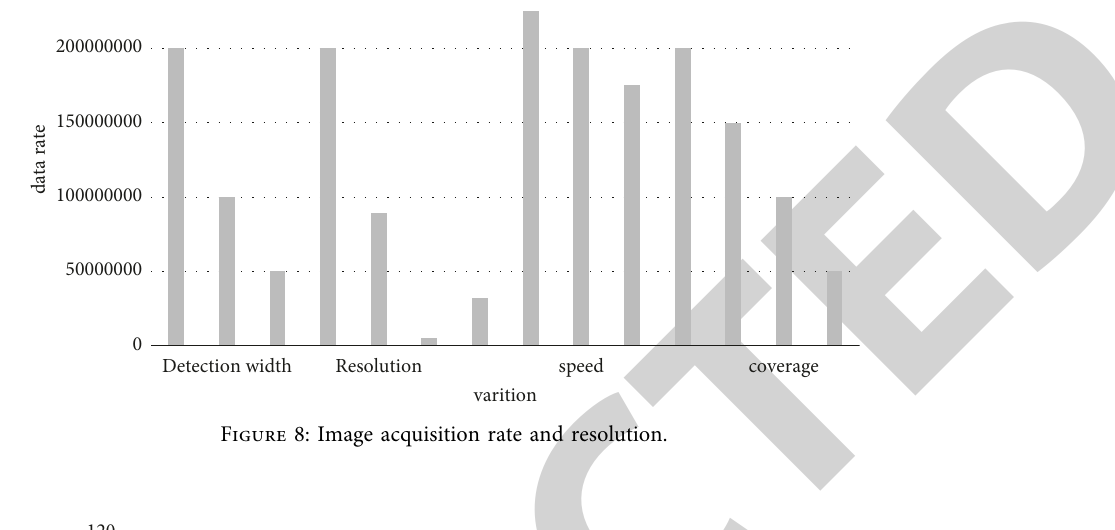
Figure 8: Image acquisition rate and resolution.